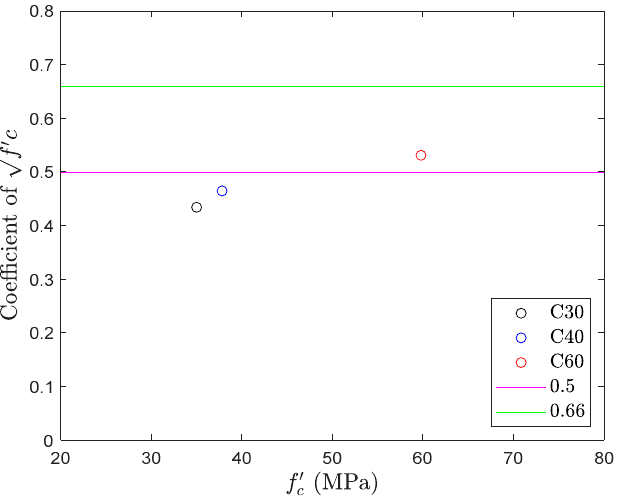
ffi cient of splitting Figure 16. (cid:1858) (cid:3030) ′ coefficient of splitting test. Figure 16. f (cid:48) c coe Figure 16. (cid:1858) (cid:3030) ′ coefficient of splitting test.